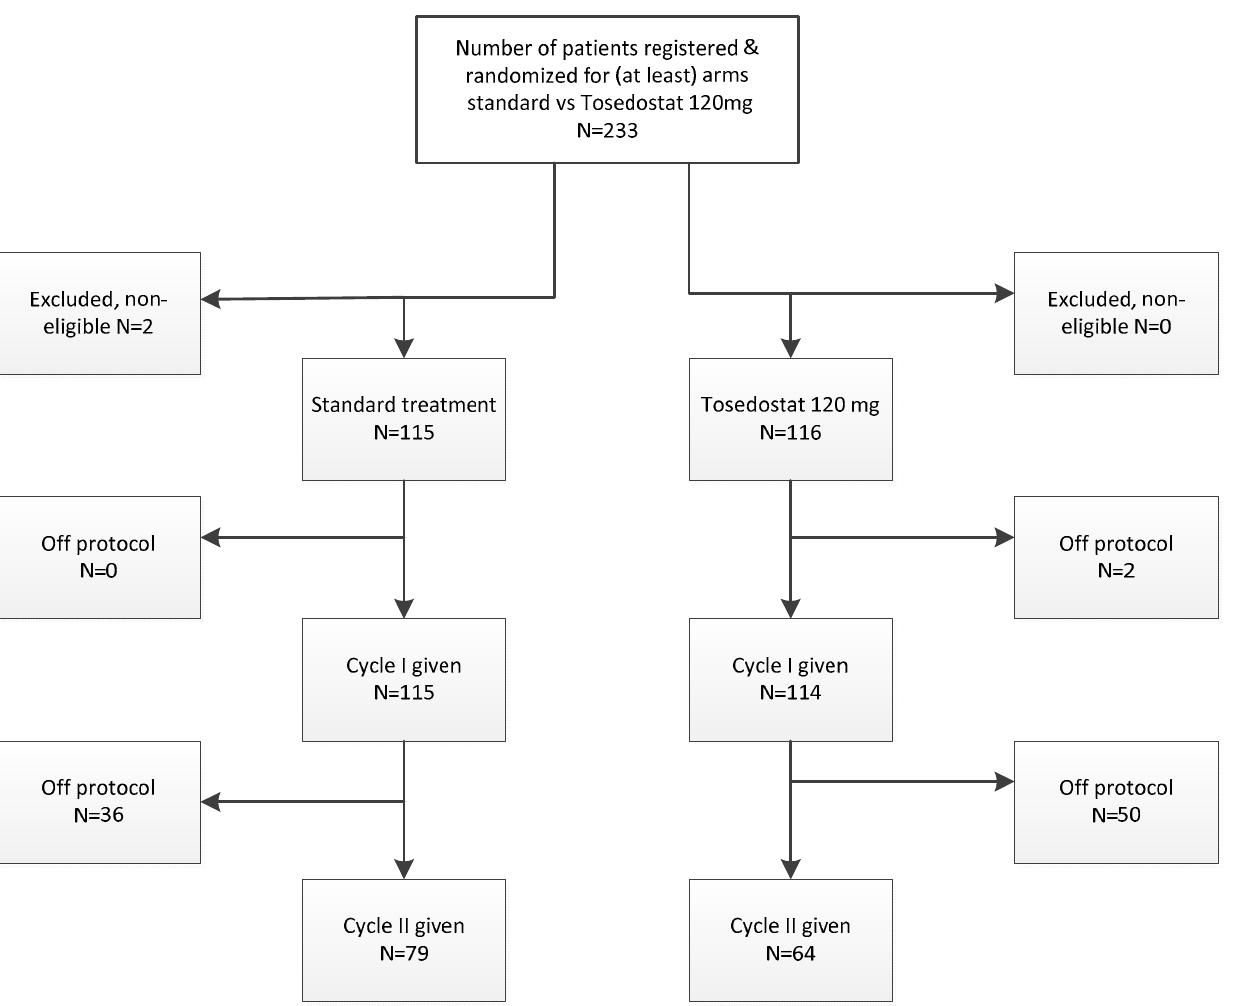
Figure 1. Consort diagram of the study. Note: the twenty-three patients that have been treated at tosedostat 180 mg qd have been excluded from this figure.